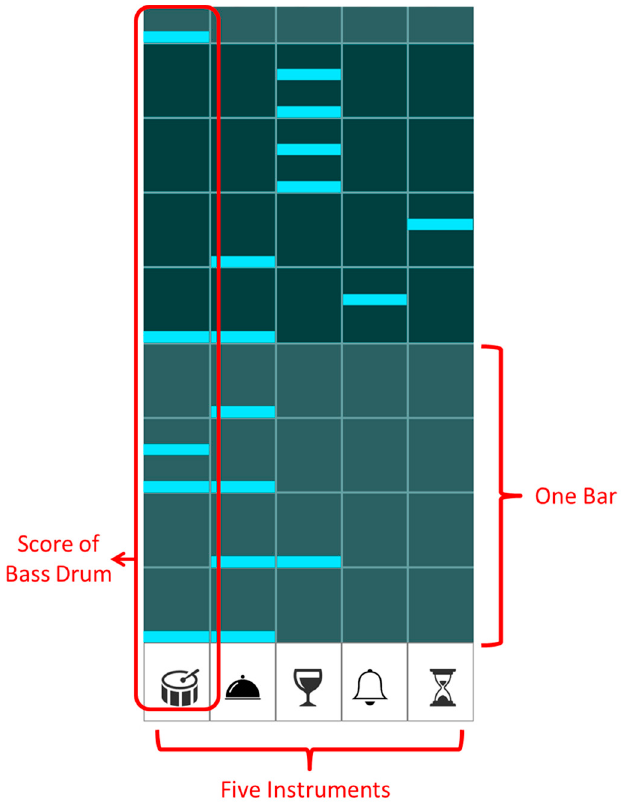
Figure 2. Musical score editing and playing functions.